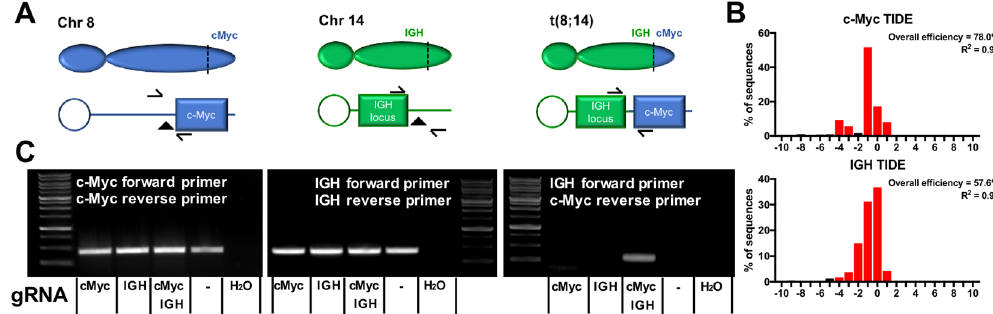
Figure 5. Simultaneous application of RNPs targeting MYC and IGH creates a t(8; 14) Burkitt Lymphoma translocation. ( A ) Diagram of relative positions of MYC on Chromosome 8 ( left diagram ), the IGH locus on Chromosome 14 ( center diagram ) and the t(8; 14) translocation ( right diagram ) associated with Burkitt Lymphoma. Arrows indicate primer direction and triangles indicate gRNA target sites. ( B ) Indel pattern and efficiency of RNPs targeting MYC ( top panel ) and IGH ( bottom panel ). ( C ) PCR amplification using MYC ( left panel ), IGH locus ( middle panel ), or a combination of MYC / IGH locus primers ( right panel ) of samples engineered with RNPs targeting MYC , the IGH locus, or a combination of MYC and IGH locus, as well as no gRNA (represented by ‘–’) and H 2 O